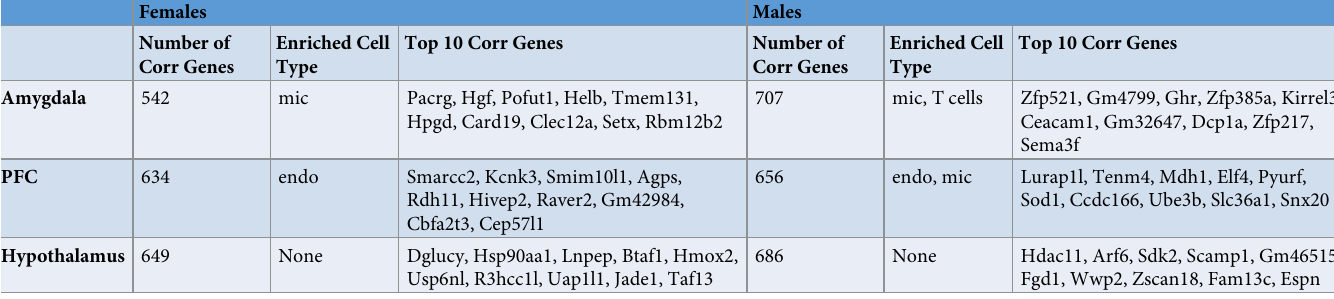
Table 1. Genes Correlated Between Blood and Brain.